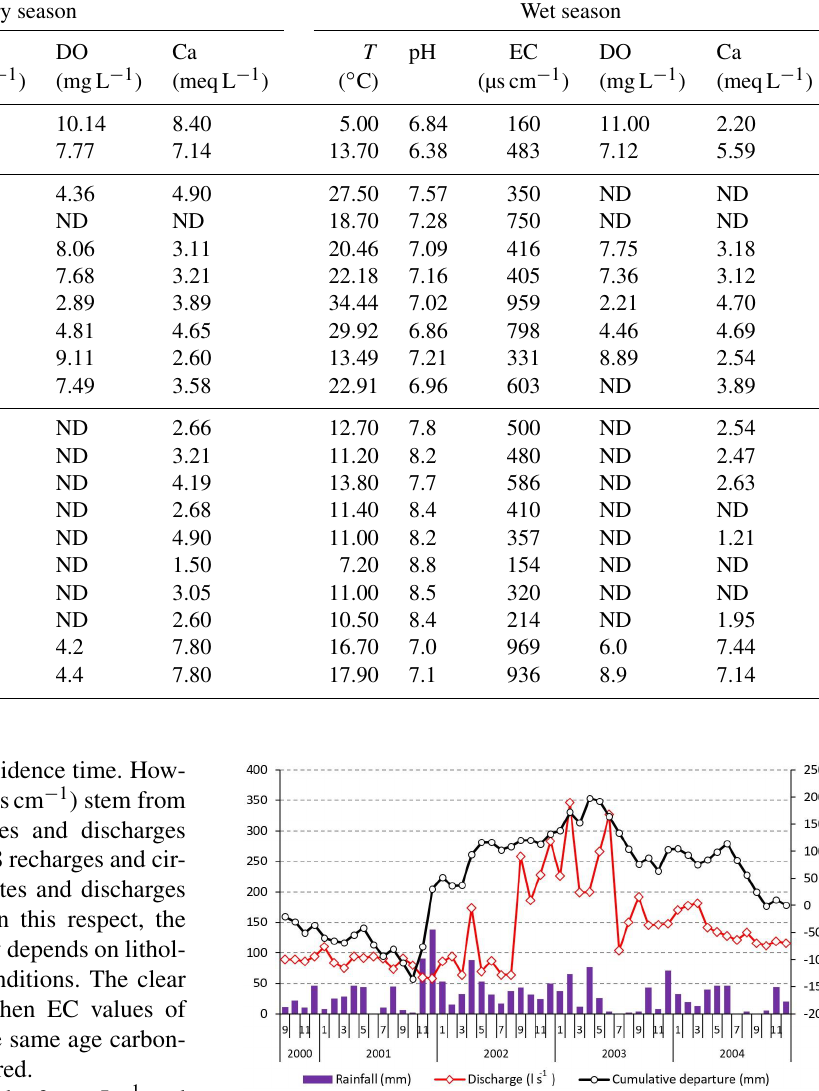
Table 3. Physico-chemical data of springs. Group